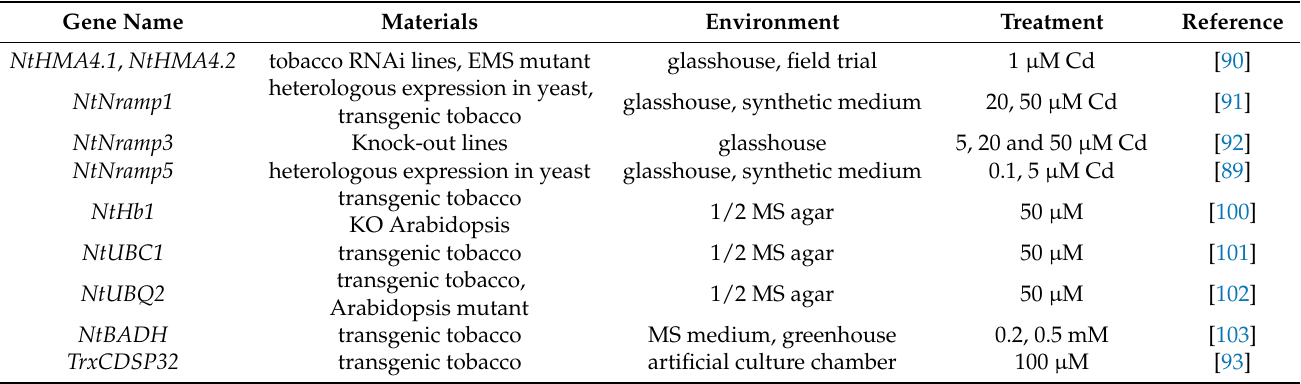
Table 2. Genes involved in Cd accumulation and tolerance in